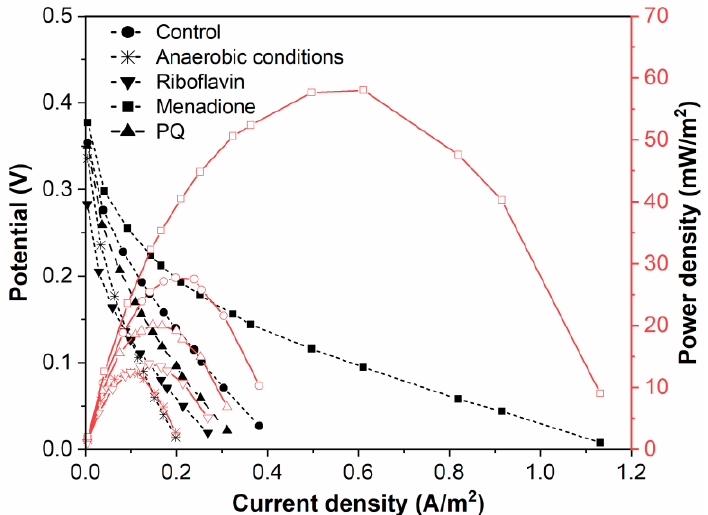
Figure 5. Polarization and power density curves of Rhizobium anhuiense -based BFC in 0.1 mM PBS, pH 7.0, in the presence of several redox mediators (5 mM of menadione, 0.2 μM of riboflavin, and 4 mM of 9,10-phenanthrenequinone) and at anaerobic conditions.